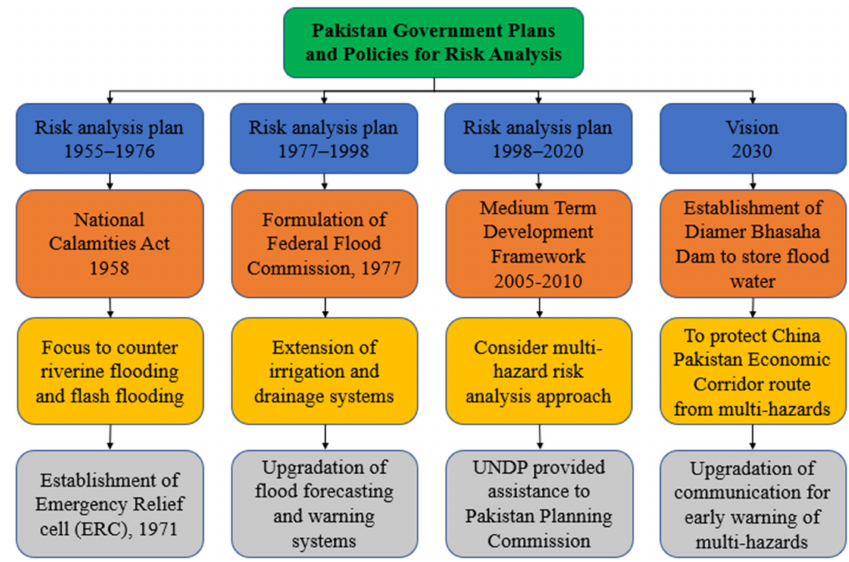
Figure 17. Risk Analysis Overview chart of the Pakistan